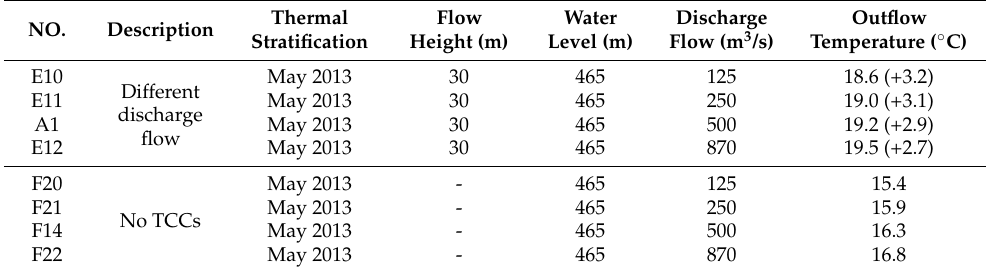
Table 8. Different discharge flow test scenarios and results.